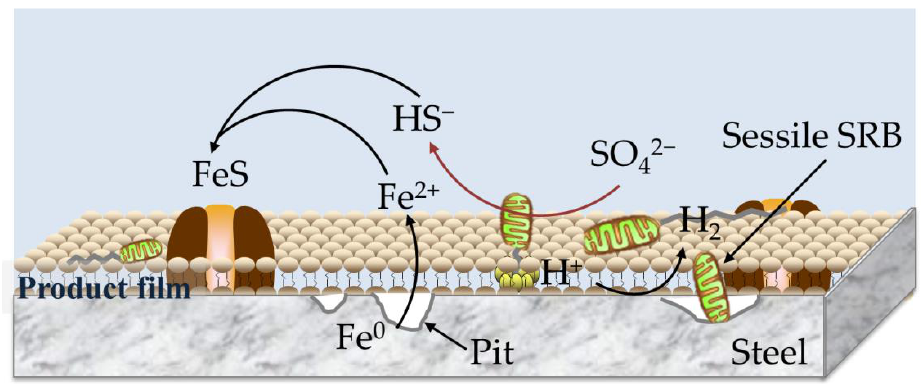
Figure 10. Mechanism model to illustrate the SRB corrosion process of X80 steel.